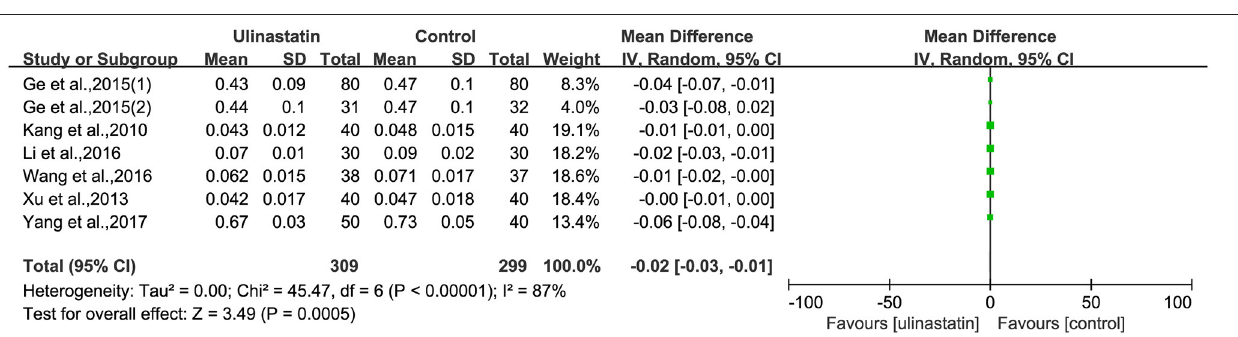
Frontiers in Neuroscience | www.frontiersin.org